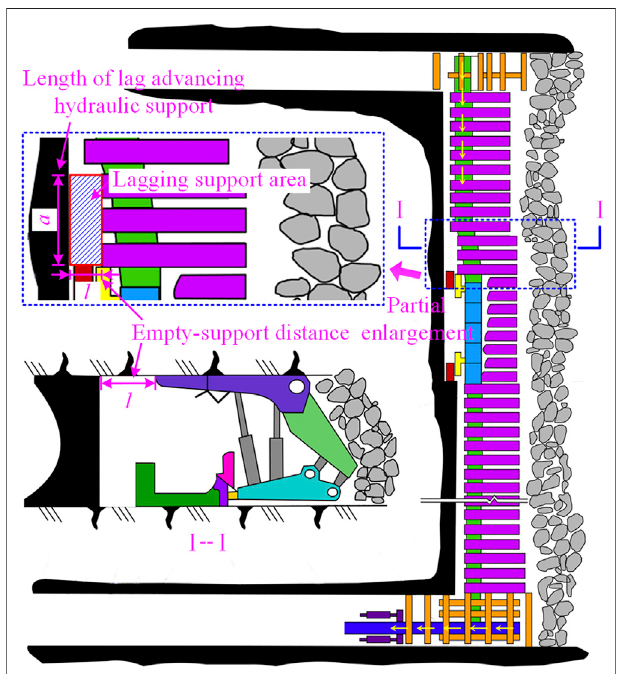
FIGURE6| Hydraulicchocksmovingforward,withadelayrelativetothe shearer.